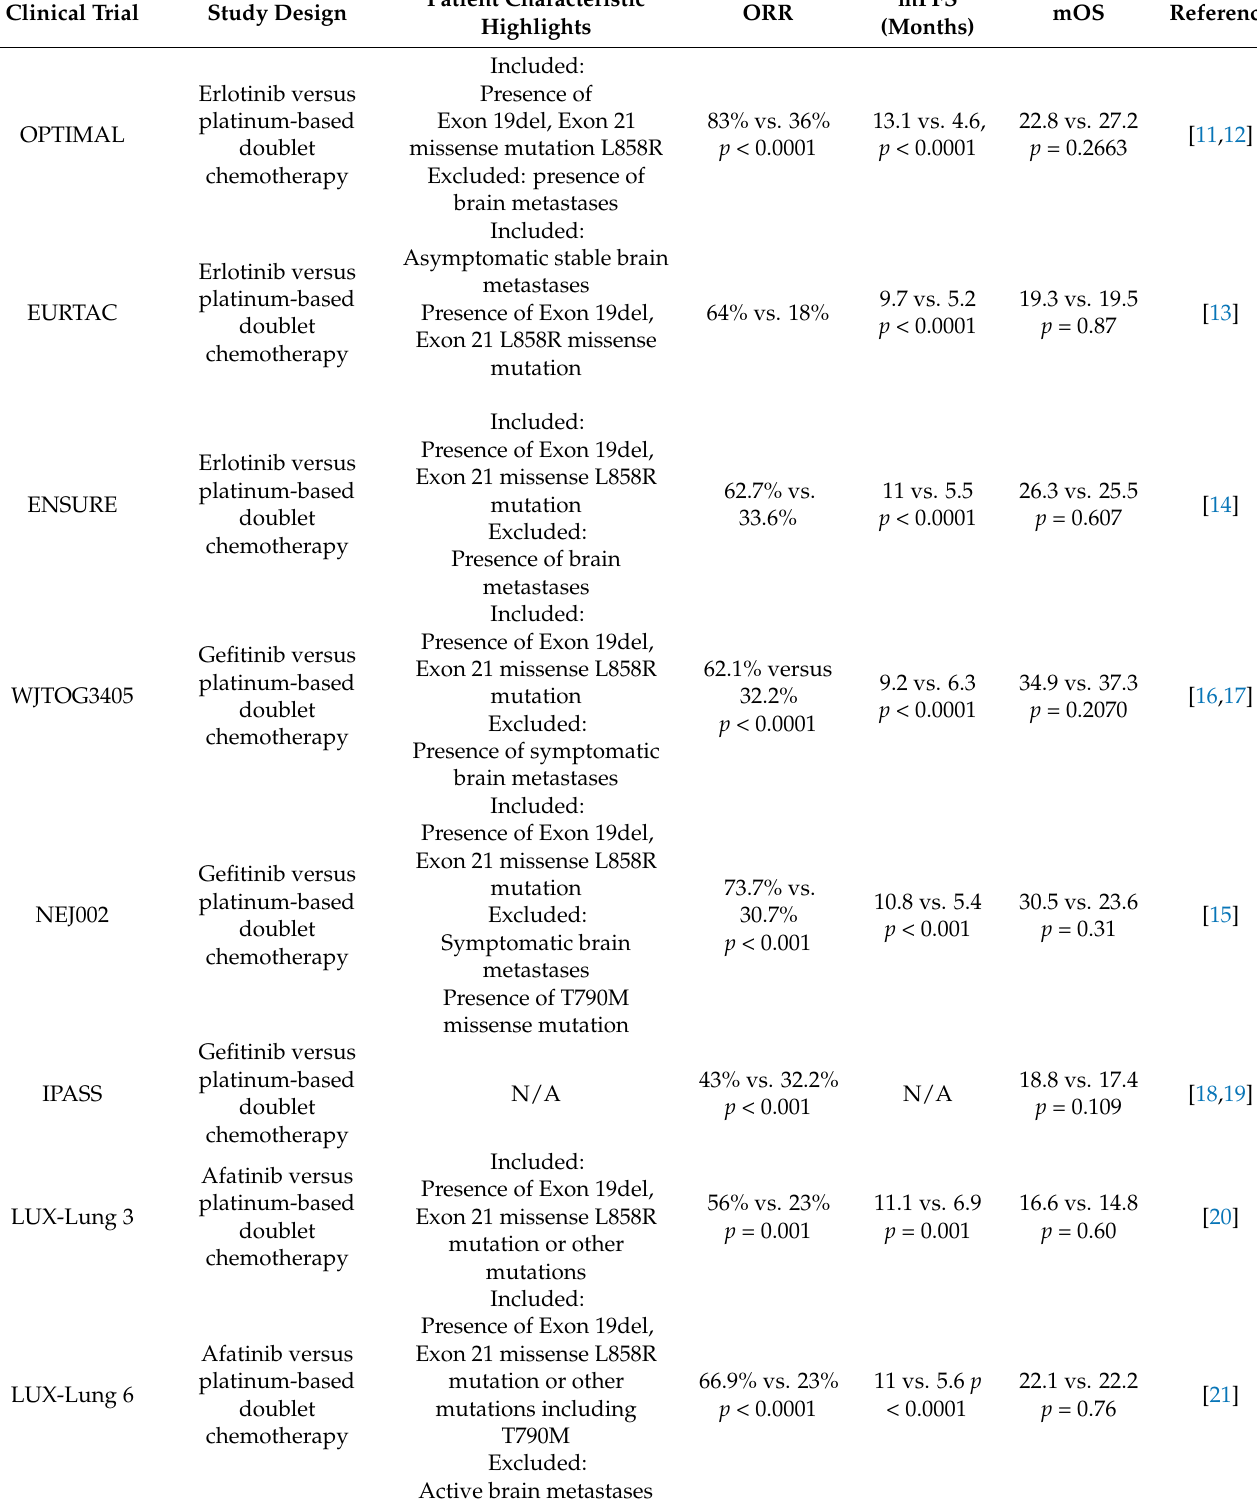
Table 1. Clinical Trials of EGFR TKIs in EGFR-mutated Lung Adenocarcinoma and Reported Outcomes. Clinical